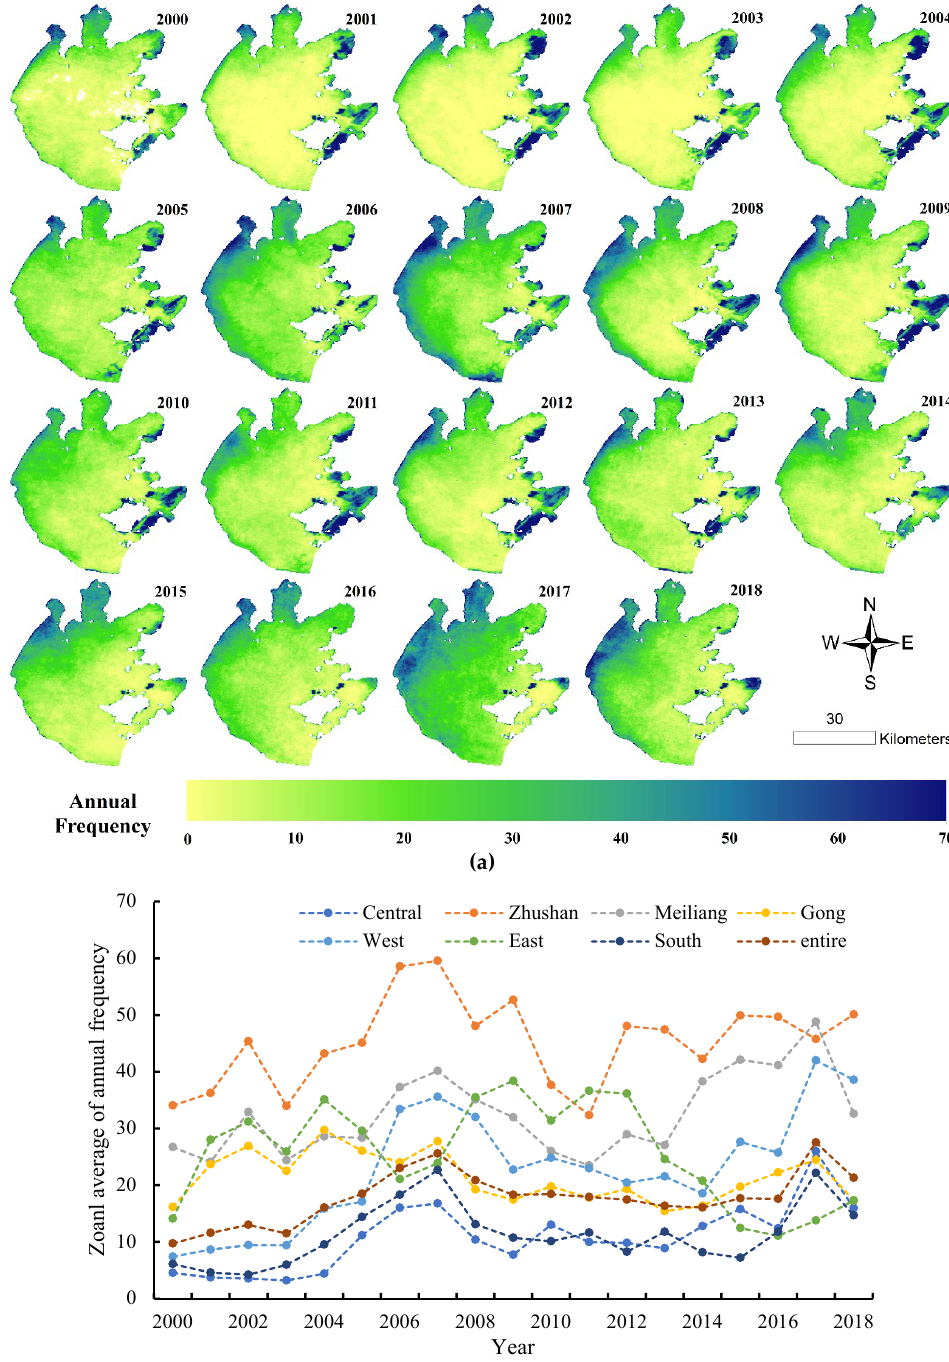
Figure 10. ( a ) Spatial annual occurrence accumulative frequency of cyanobacteria blooms and ( b ) zonal average statistics of spatial annual occurrence frequency of cyanobacteria blooms. Cyanobacteria blooms are defined as when a pixel’s FAI is > − 0.004. The results in East Lake and Gong Bay are due to both cyanobacteria blooms and macrophytes, the same as the initial and duration results in Section